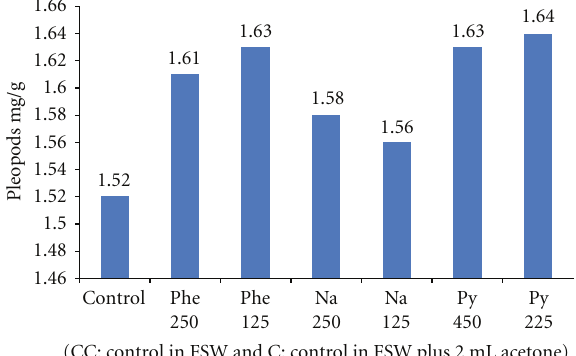
Figure 7: Mean DNA concentration of L. vannamei exposed to